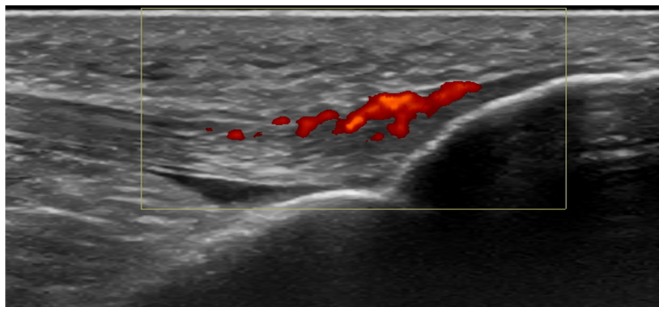
Positive power Doppler signal identifying tibial tuberosity enthesitis.The signal (in red) is detected in the tibial insertion of the patellar ligament in one of the studied patients.